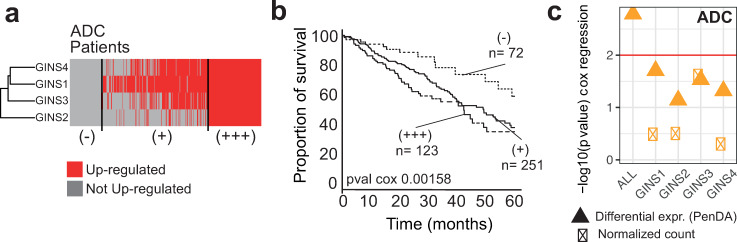
Synergic effects of gene deregulation within a protein complex.(a) Heatmap showing the distribution of gene deregulations of genes coding for the GINS complex in the ADC cohort. Patients are ordered from left to right according to an increasing number of gene deregulations within the GINS complex. The patients were separated into discrete deregulation groups of: 0 up-regulation (-), 1–3 up-regulations (+) and 4 up-regulations (+++). (b) Survival of ADC patients according to the deregulation groups defined in (a). (c) Cox regression p-values associated with different models (multivariate and univariate). Cox regression is applied on PenDA deregulation matrix (triangles) or expression matrix (ticked boxes, normalized count values). ALL corresponds to a multivariate cox model including the four genes of the GINS complex. The red line corresponds to the significance level of 0.01.